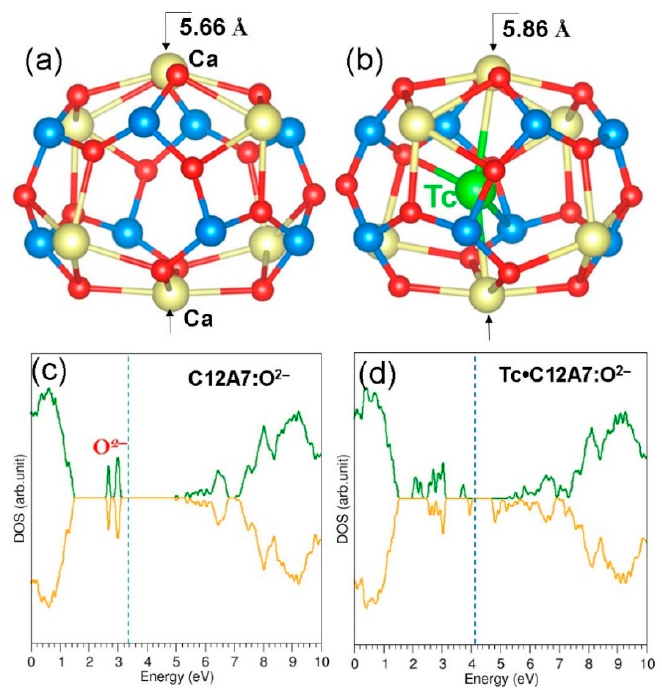
Figure 2. ( a ) and ( b ) Optimised structures of an empty cage and a cage containing a Tc atom, respectively, showing the Ca–Ca cage pole distance; ( c ) and ( d ) density of states (DOS) plots calculated for C12A7:O 2 − and Tc:C12A7:O 2 − , respectively. The vertical blue dotted lines correspond to the Fermi energy.